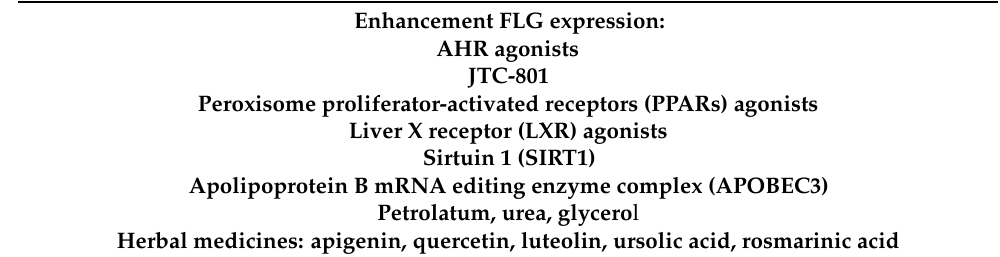
Enhancement FLG